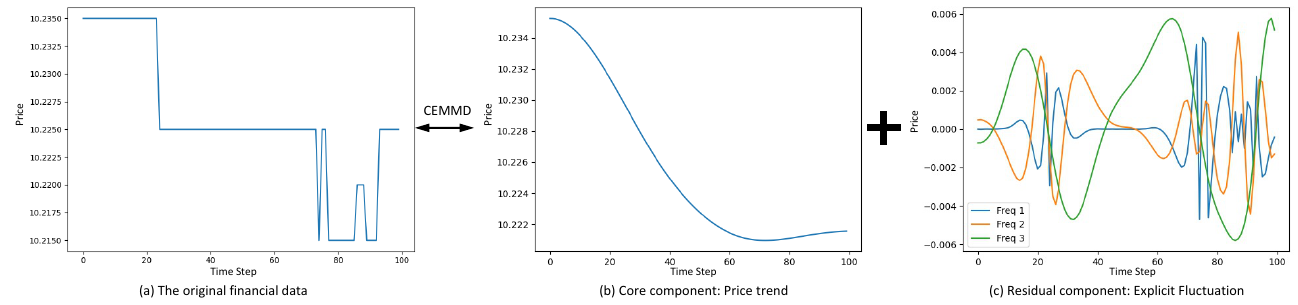
Figure 1. The illustration of decomposition for complete ensemble empirical mode decomposition (CEEMD): ( a ) The original financial sequence data is decomposed into: ( b ) a trend component, and ( c ) several mode